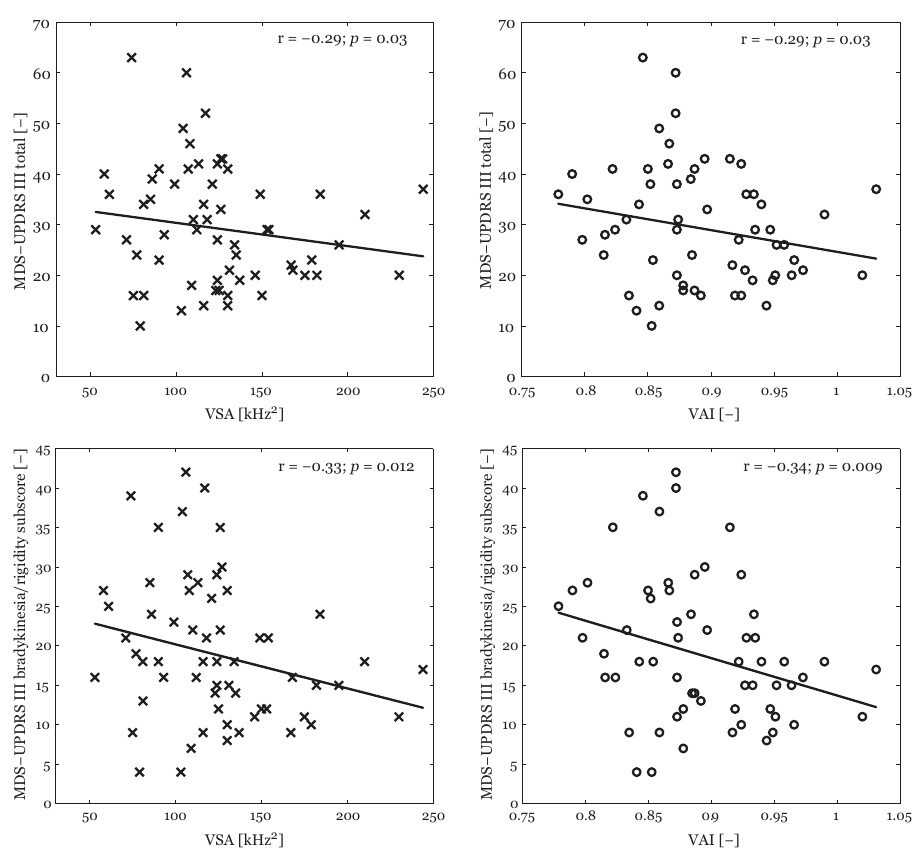
Fig. 3 Signi fi cant correlations between clinical motor scales and acoustic data plotted to 2D space with the trend of averaged data (black line) in the PD group. VSA Vowel space area, VAI Vowel articulation index, MDS – UPDRS III Movement Disorder Society – Uni fi ed Parkinson ’ s Disease Rating Scale part